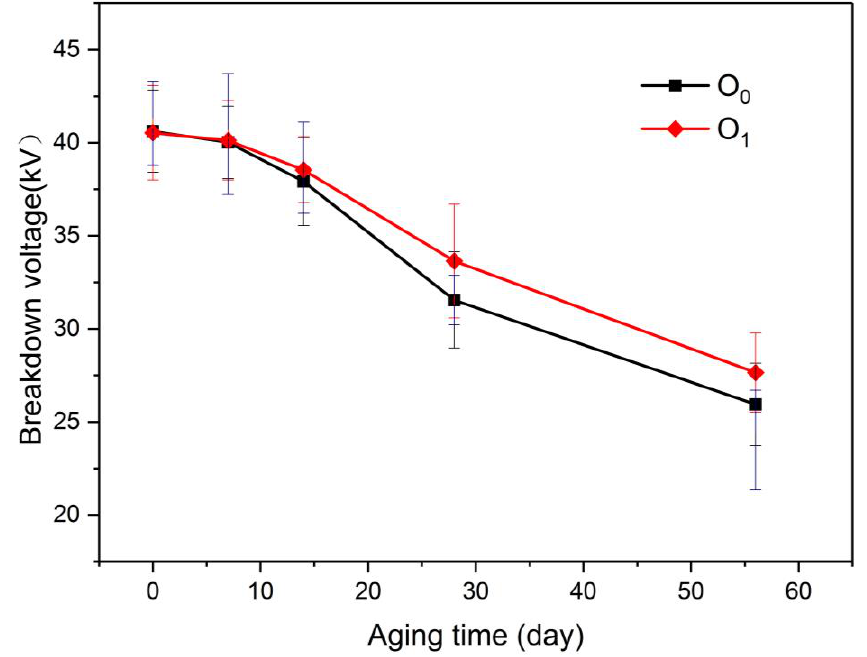
Figure 7. Variation of breakdown of voltage in oil with aging process.